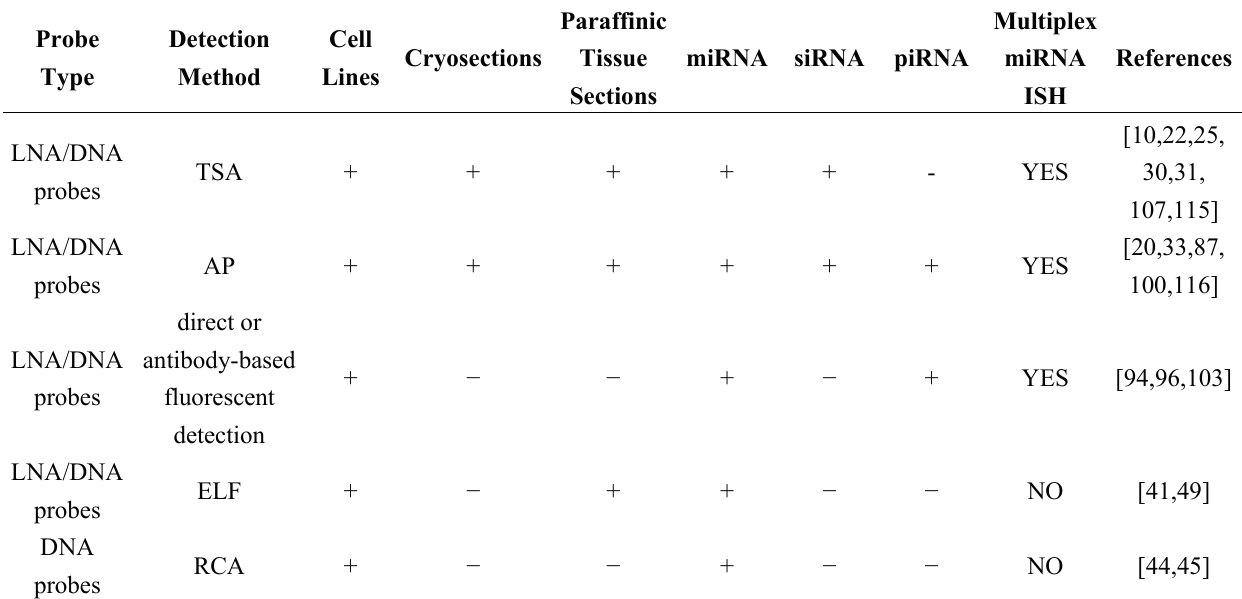
Table 2. Detection of small RNAs and biological material used with selected in situ hybridization (ISH)